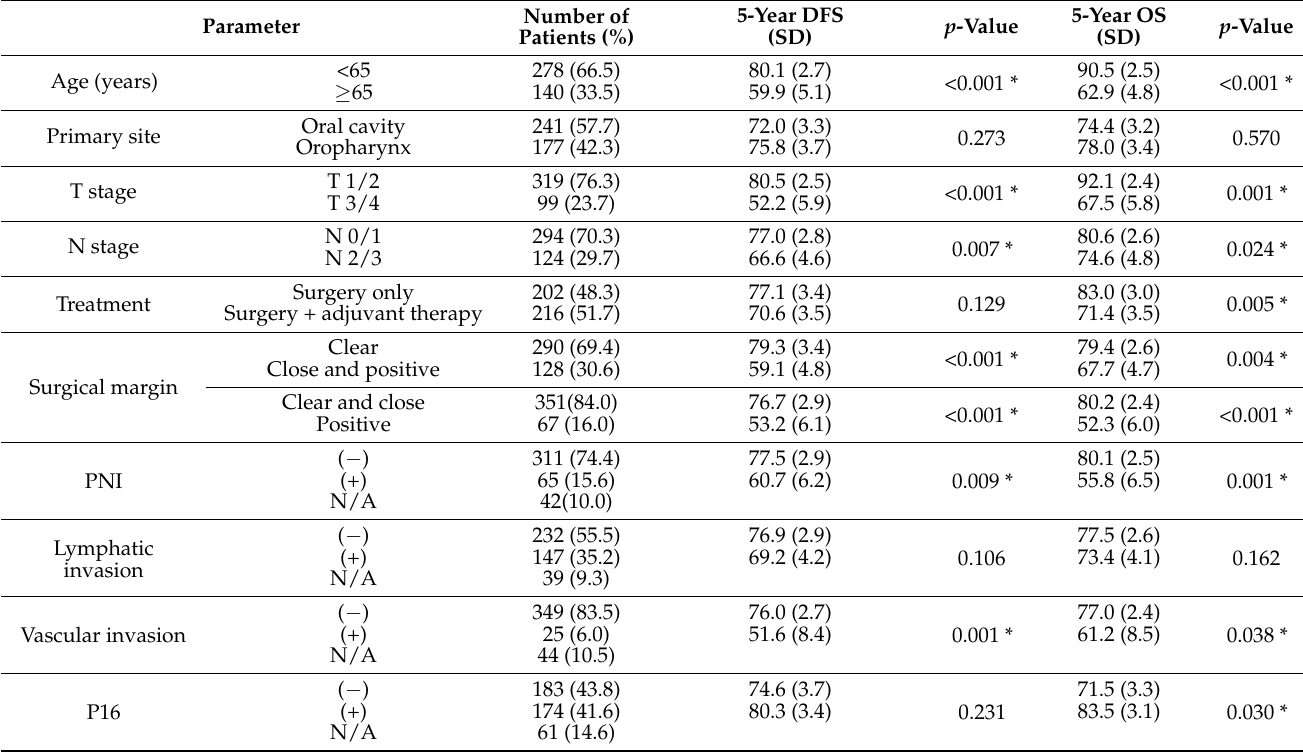
Table 3. Univariate analysis of parameters predicting the prognosis of oral and oropharyngeal cancer patients ( n =